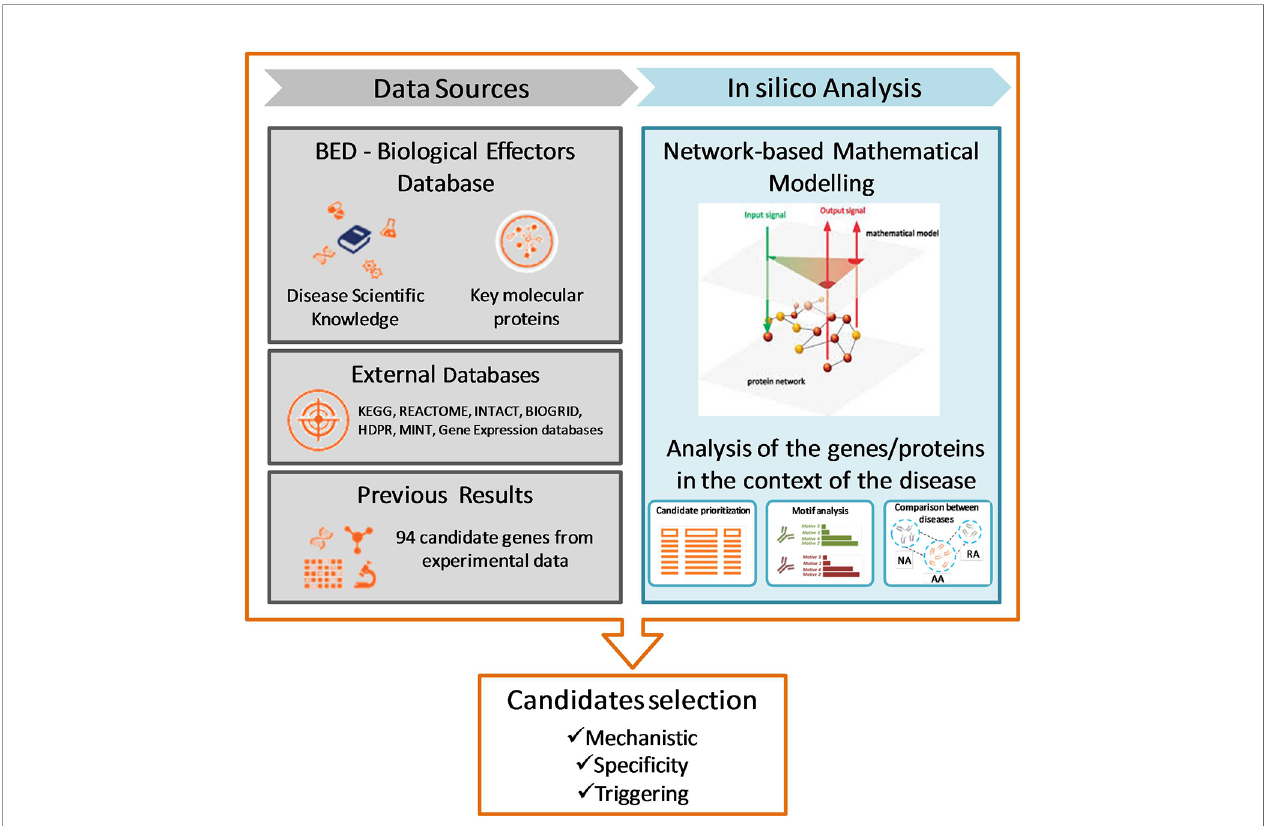
FIGURE 1 | Study design and work fl ow of systems biology study. NA, non-allergic Asthma; AA, Allergic Asthma; RA, Respiratory Allergy. [Based on Gimenez et al.